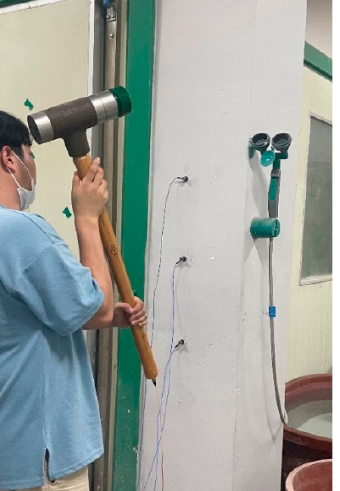
Figure 7. Impact hammer test.